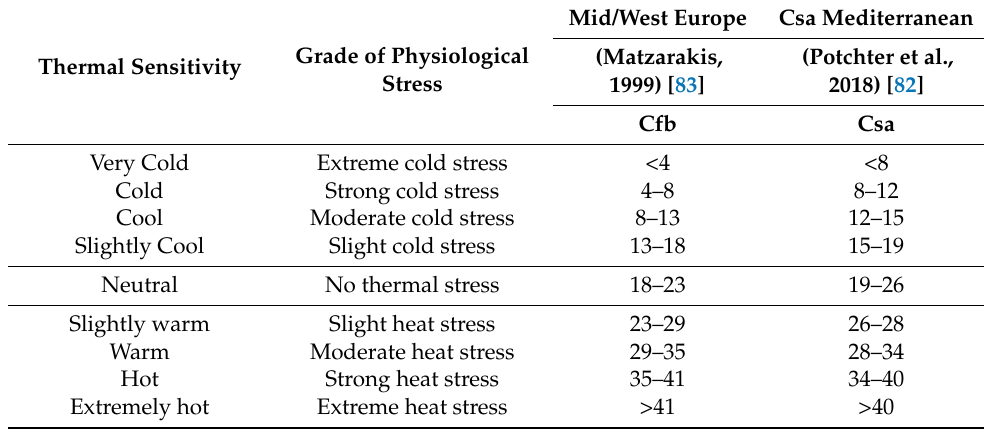
Table 7. PET range for Middle/Western Europe and the adjusted PET for the Mediterranean